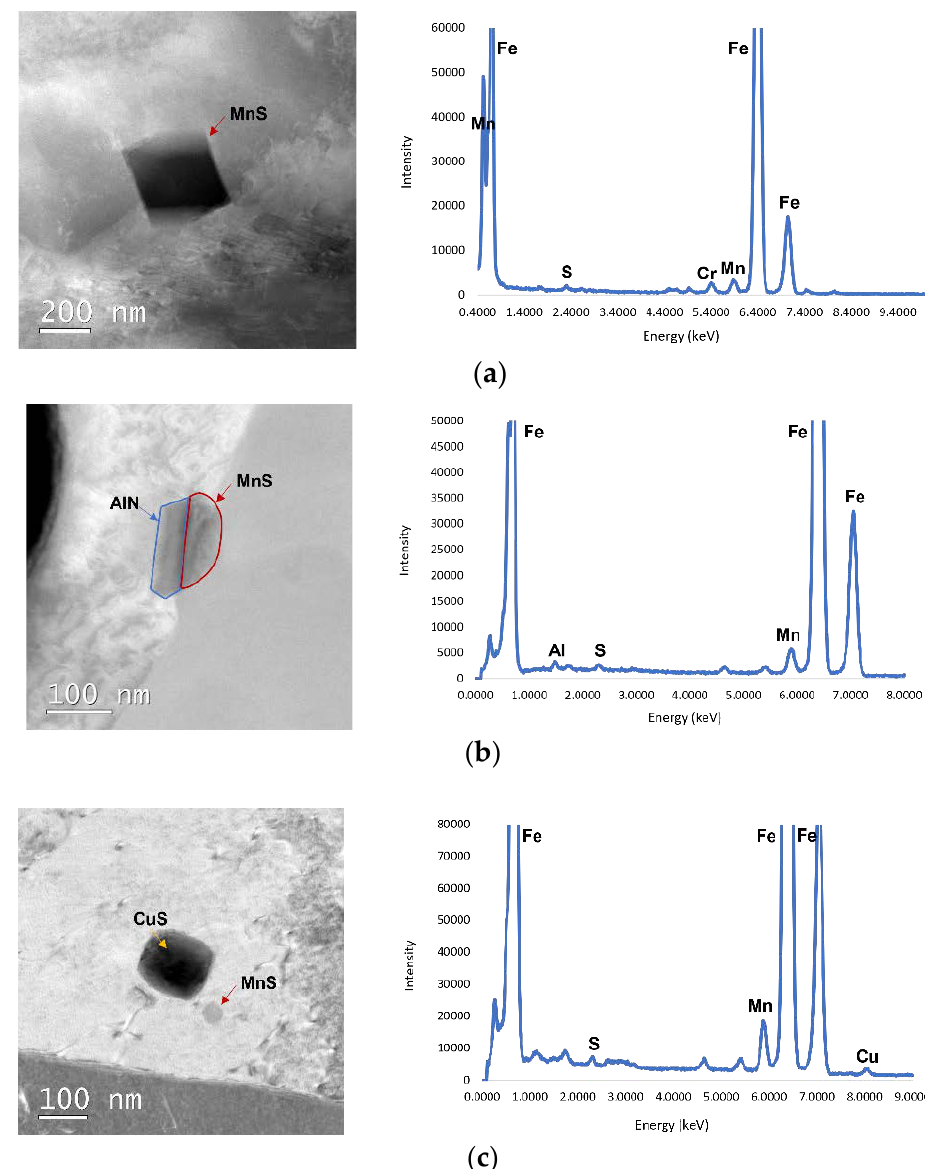
Figure 7. Precipitates in steel A: ( a ) MnS; ( b ) AlN at MnS; ( c ) CuS and MnS. The investigations in steel B also confirmed the presence of the precipitates predicted by the MatCalc simulations, TiN and BN, but also some very fine complex precipitates identified as (TiV)N, also shown by Pandit et al. [36]. The size of these complex precipitates was measured to be approx. 10 nm, and TiN were between approx. 150 and 250 nm at the grain boundaries, which is approximately in the same range as reported by Poths et al. [37] and around 1 µ m in the matrix. The BN identified were approximately 800 nm in size, similar to the results obtained by Den é s et al. [38]. BN were much more difficult to be found due to the low atomic mass of B, a problem known and reported by other authors [38,39]. With a low acceleration voltage and beam energy, some of these precipitates could be identified, and example images are shown in Figure 8. From the analysis, it can be said that there were many more TiN precipitates present in the steel compared to BN precipitates and that at the grain boundaries, only TiN were present. Moreover, BN seen in the matrix were all at the pockets of Al 2 O 3 inclusions, as shown in Figure